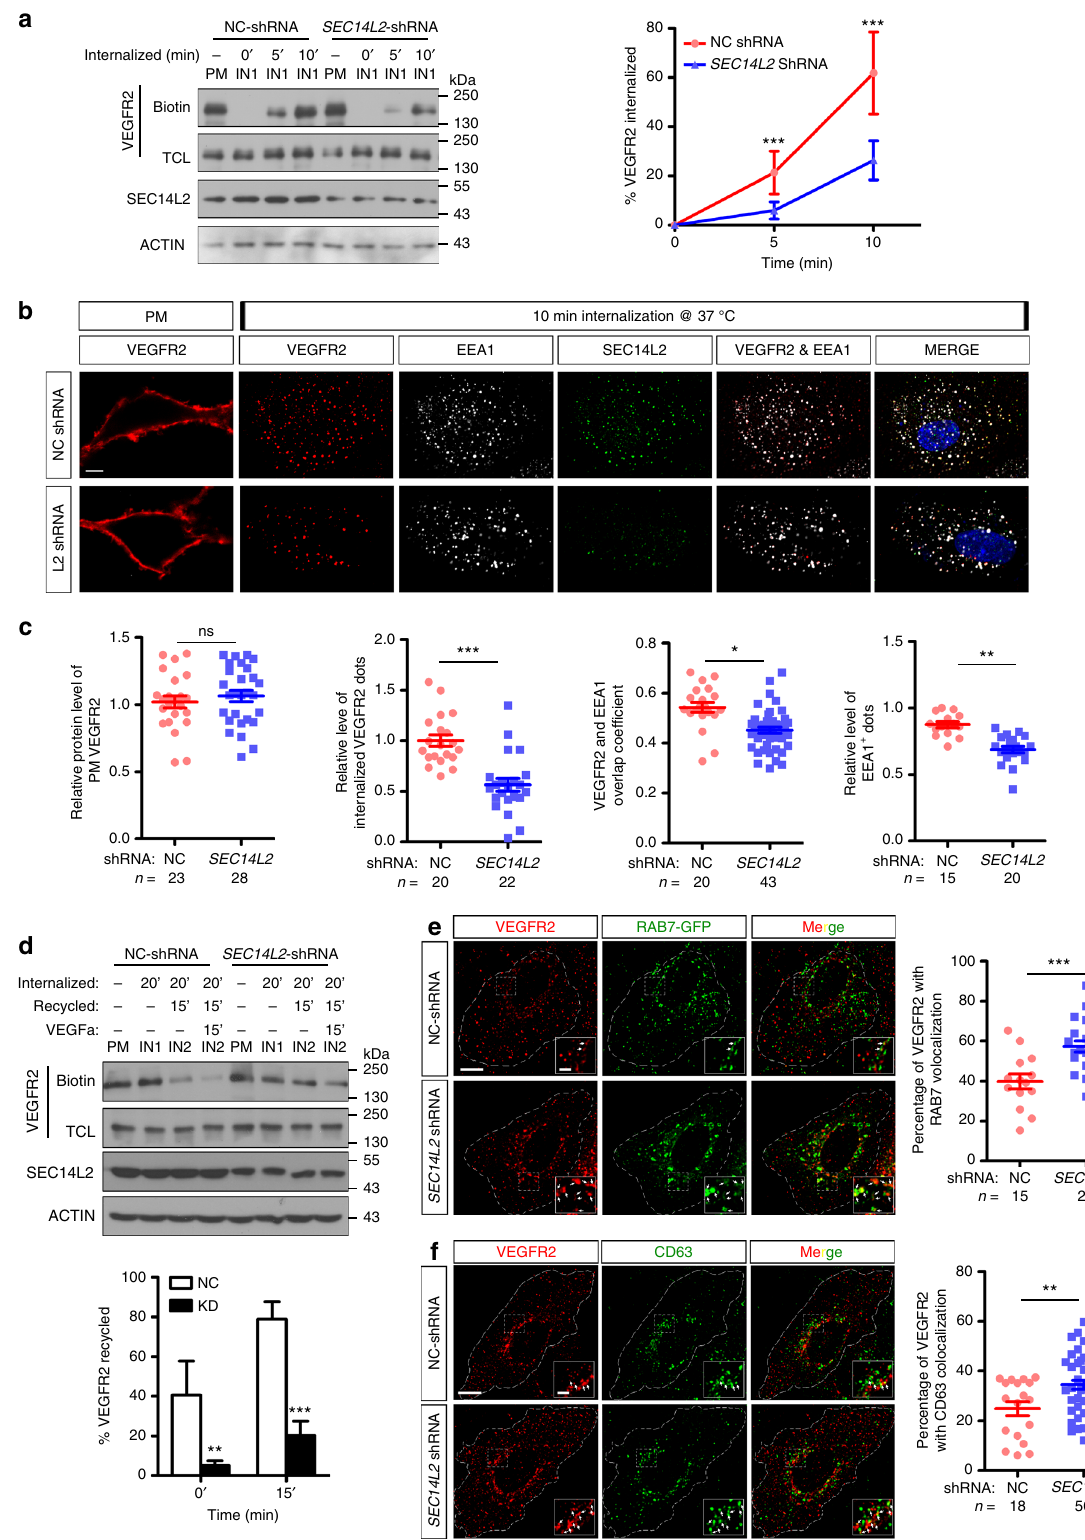
vasculature morphogenesis in zebra fi sh embryos in vivo and vascular tubulogenesis in vitro. The effective induction of VEGF signaling through overexpression of cytoplasmic region of VEGFR2 mRNA or suppression of ptp1b expression or over- expression of constitutively active MEK/AKT partially restored the narrowed DA and PCV lumens in zebra fi sh sec14l3